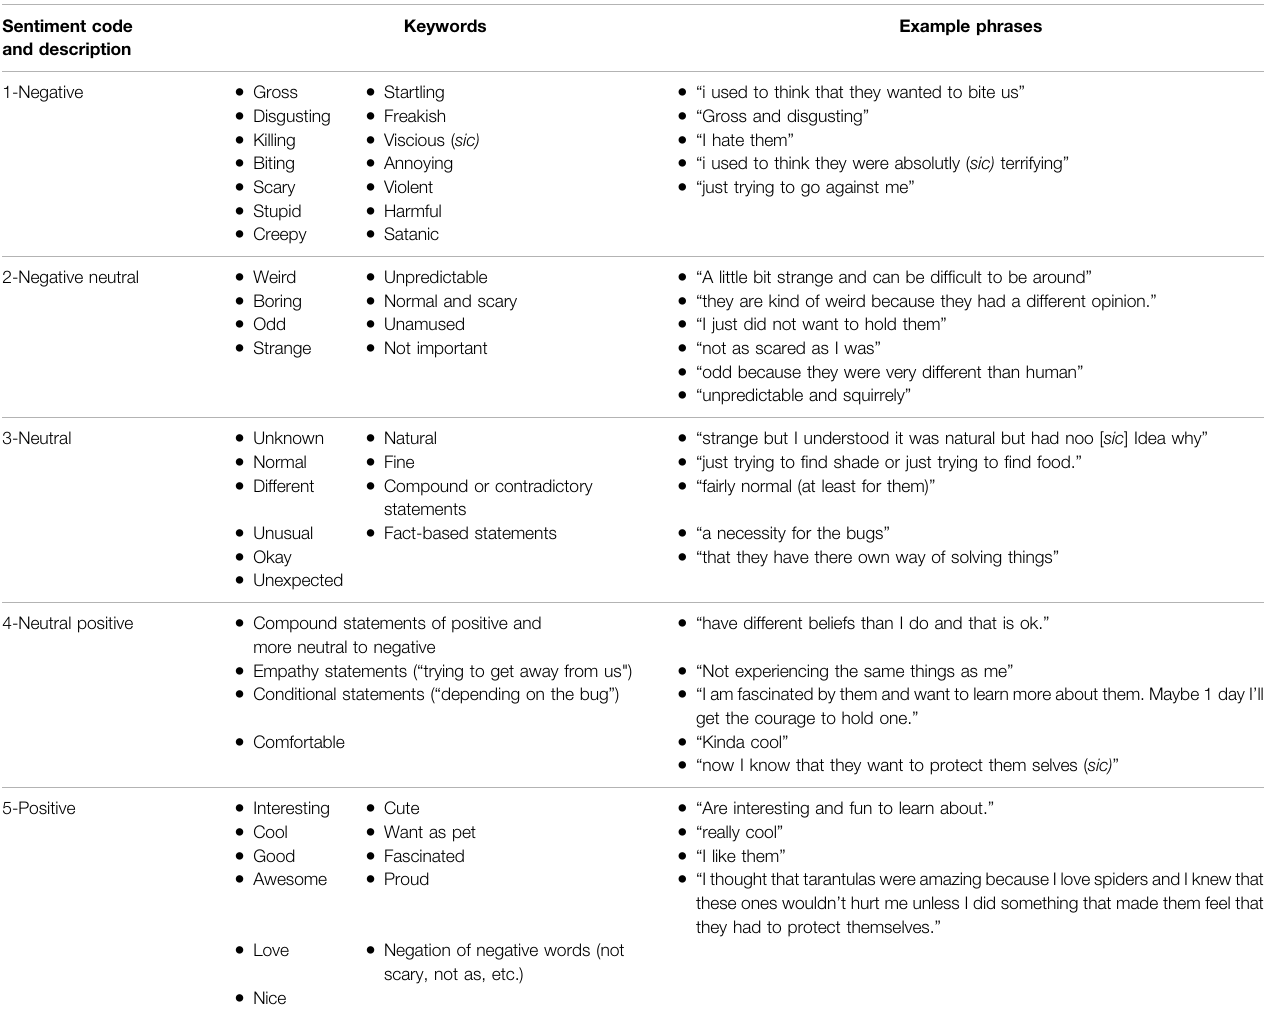
TABLE 2 | Code matrix with keywords and example student answers. Sentiment code and